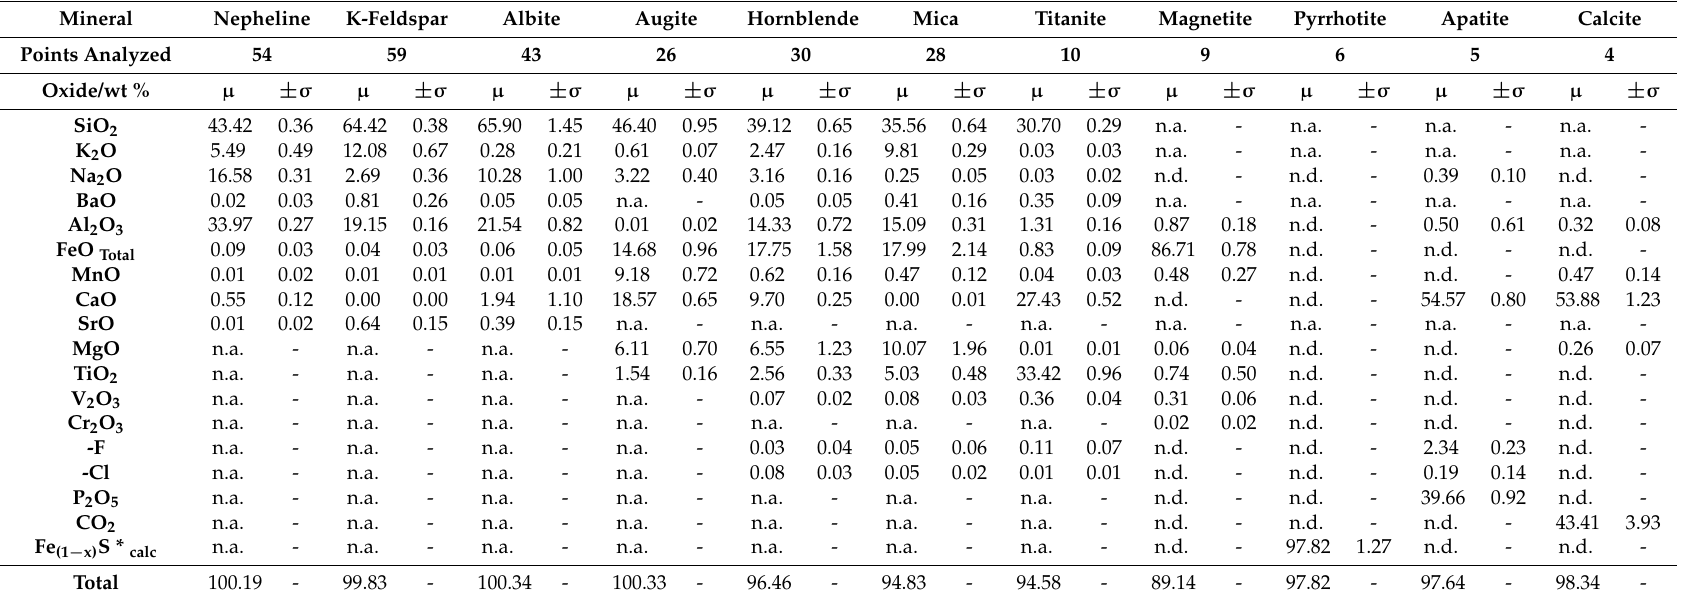
Table 5. Average and standard deviation of mineral chemical composition from mineral list in Table